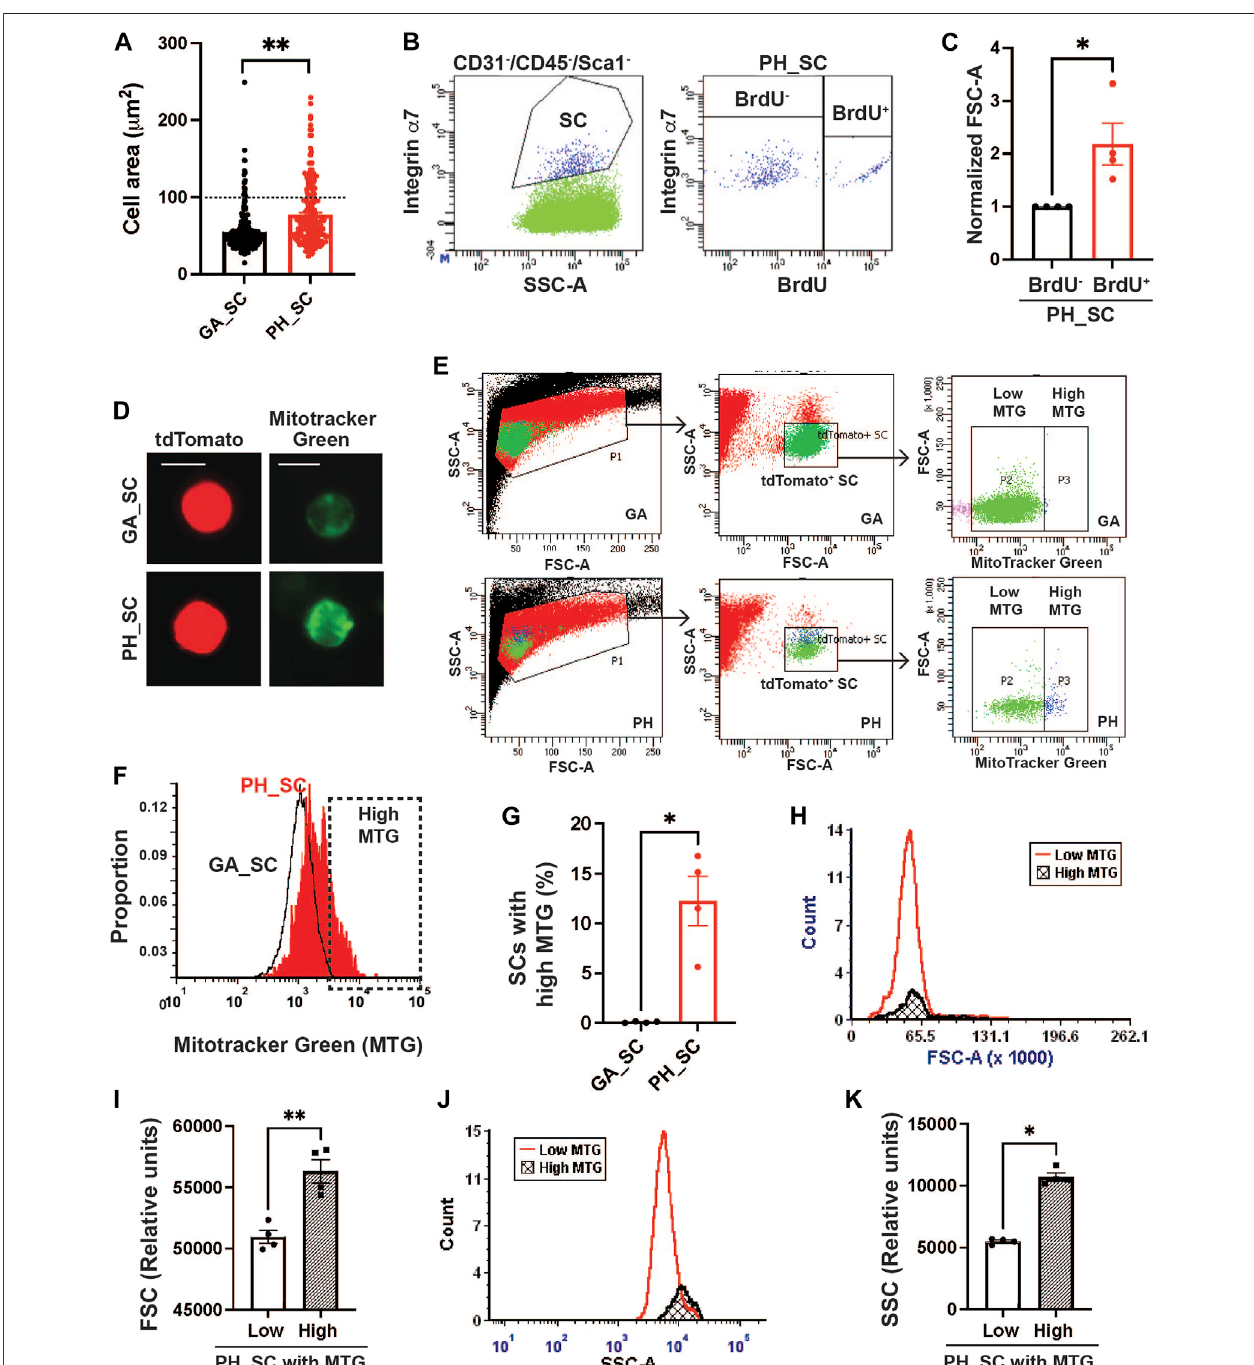
FIGURE1| Asubset ofpharyngealsatellitecellsareenlargedand containabundant mitochondria. (A) Measured cellarea(µm 2 )ofpharyngeal (PH_SC)( n =3,219 cellswereanalyzed)and gastrocnemiusSCs(GA_SC)( n =3,268cellswereanalyzed)of3 monthsold Pax7CRE ERT2 -tdtomato miceusing cytospin. (B) Representative scatter plot showing gating strategy for pharyngeal satellite cells (SC) (Left) and BrdU + pharyngeal satellite cells (Right). Satellite cells were isolated from 3 months old C57/BL6 mice. (C) Comparison of forward scatter (FSC-A) values between BrdU + pharyngeal SC and BrdU − pharyngeal SCs. FSC-A values were normalized to BrdU − pharyngeal SC ’ s FSC. (D) Microscopic fl uorescence images showing tdToamto expressing SCs from gastrocnemius or pharyngeal muscles mitochondria stained with MitoTracker Green. Scale bars = 10 µm. (E) Represntative fl ow gating for tdTomato + GA SC and PH SC (green dots) with high (blue dots) and low MitoTracker Green intensity. (F) Representative fl ow cytometry histogram of MitoTracker Green fl uorescence levels of both gastrocnemius (black line) and pharyngeal (redline)SCs.TheHighMTGgateindicatestheSCpopulationwithhighlevelsofMitoTrackerGreen. Satellitecellswereisolated from3 months Pax7CRE ERT2